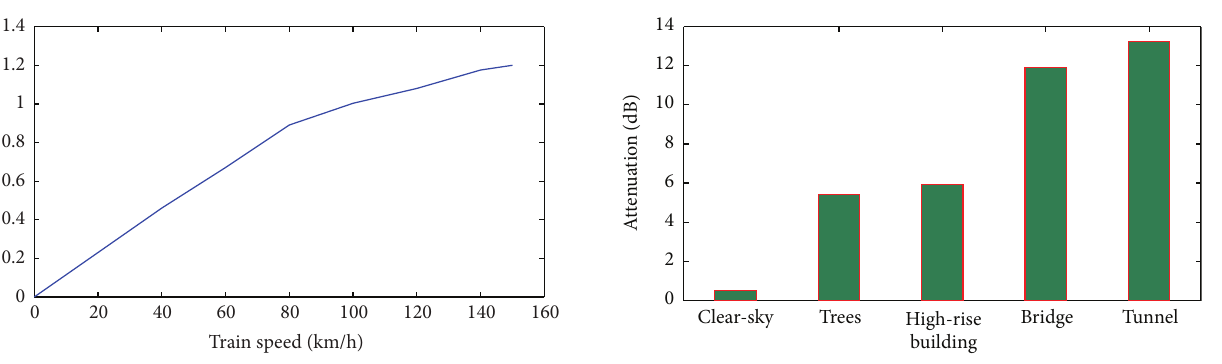
Figure 17: Attenuation due to different link obstacles with speed of 150 km/hr.